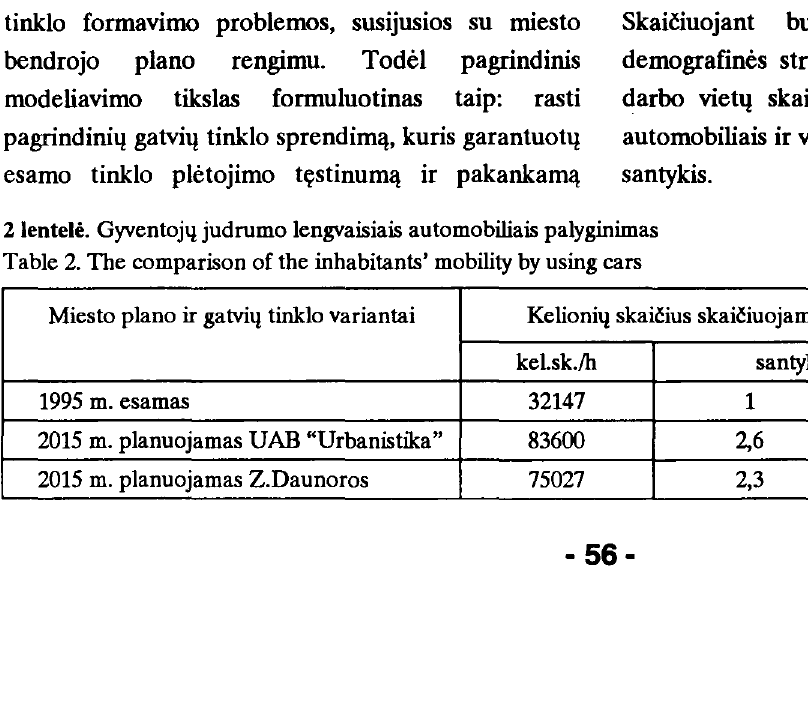
Table 2. The comparison of the inhabitants' mobility by using cars Miesto plano ir gatviq tinklo variantai Kelioniq skaicius skaiciuojamojo piko valandll